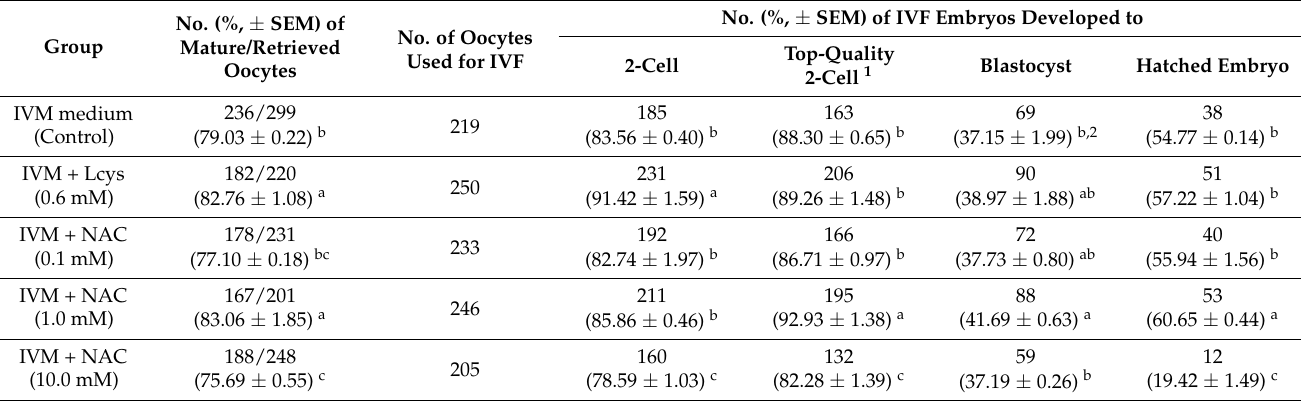
Table 2. Effect of different concentrations of NAC in IVM medium on bovine oocyte and embryo development.